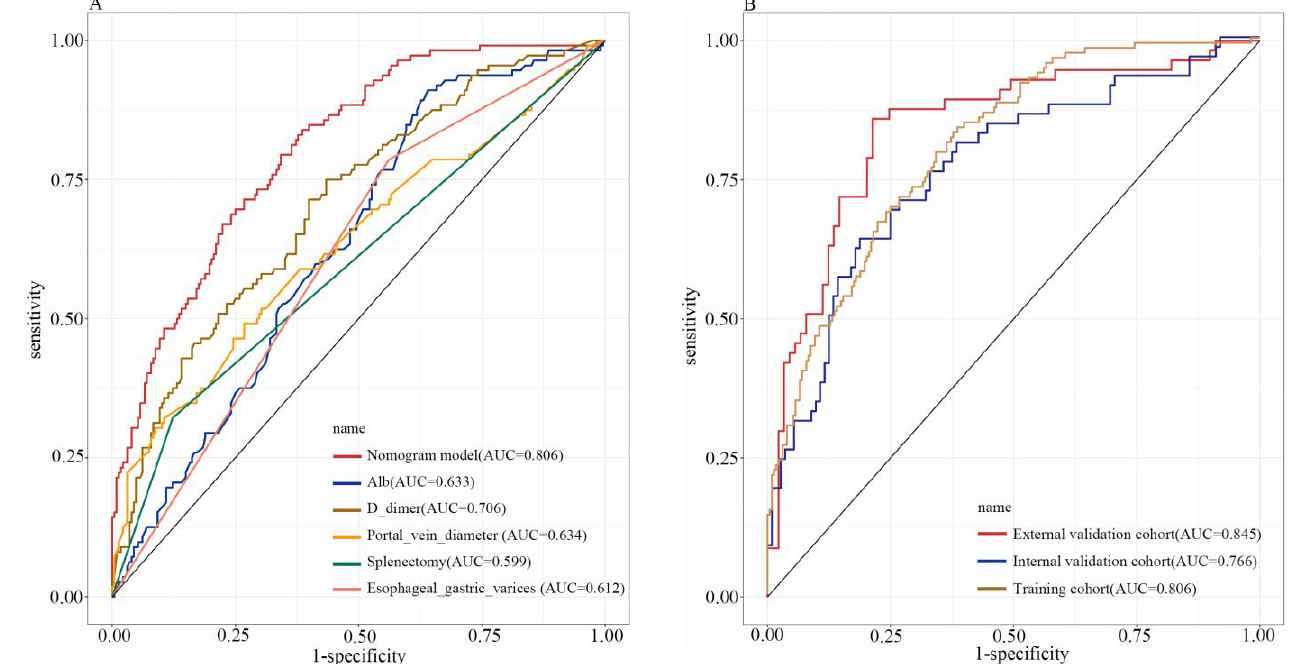
Figure 3. The ROC curves of independent risk factors based on multivariate analysis and nomogram model in the training cohort ( A ). The ROC curves of nomogram used in the three different cohorts ( B ).